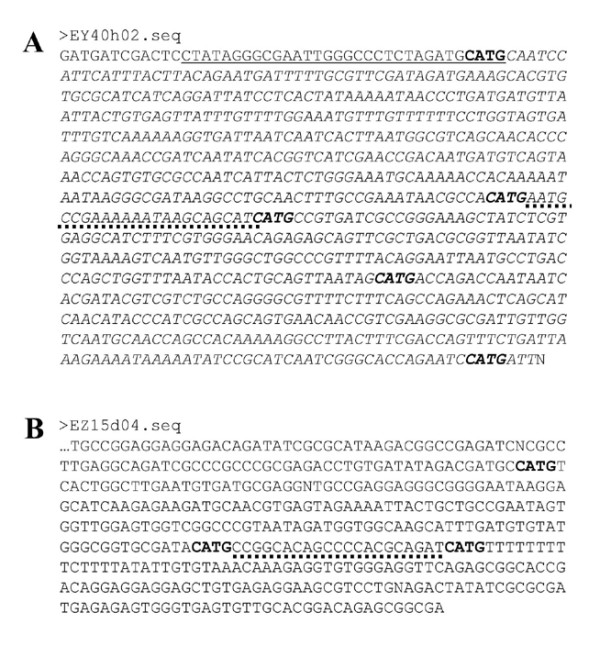
Raw SAGE sequence data showing cloning and potential sequencing artifacts not excluded by SAGE software. (A) Clone with fragment of E. Coli genomic DNA. Italics denote E. Coli sequence (AE000307). (B) Clone with unidentifiable insert, which lack normal SAGE concatemer. Sequences like (A-B) represent quasi-ditags that should have been removed. pZErO-1 sequence is underlined; Anchoring enzyme recognition sites (AERS(CATG)) are shown in bold, and potential SAGE tags are shown by dotted underlines.